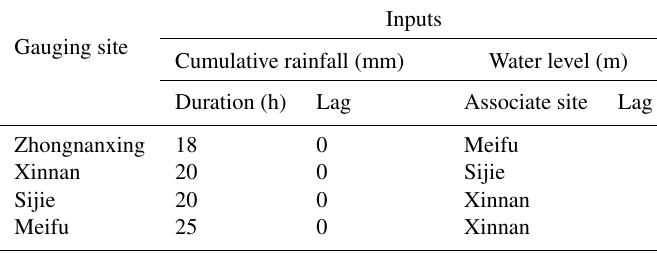
Table 5. Input variables for the water-level forecast